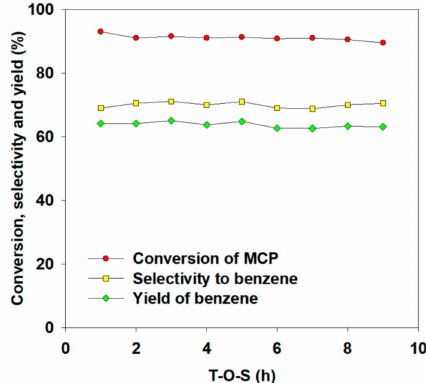
Figure 13. Conversion of MCP, selectivity to benzene and yield of benzene over Pt / (HZSM-48 + pseudoboehmite, 1:1) catalyst. (reaction condition: H 2 / MCP (mol / mol) 10, temperature 450 ◦ C, pressure 1 atm, and WHSV 0.3 h − 1